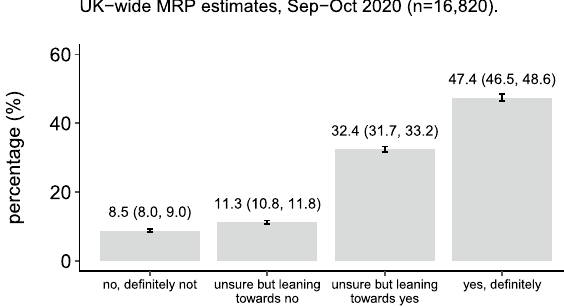
Figure 1. National-level estimates of COVID-19 vaccine uptake intent. National-level estimates for the percentage of the UK that would “definitely not” accept a COVID-19 vaccine, “definitely” accept a COVID-19 vaccine, or who are unsure. Mean MRP estimates with 95% highest posterior density intervals are